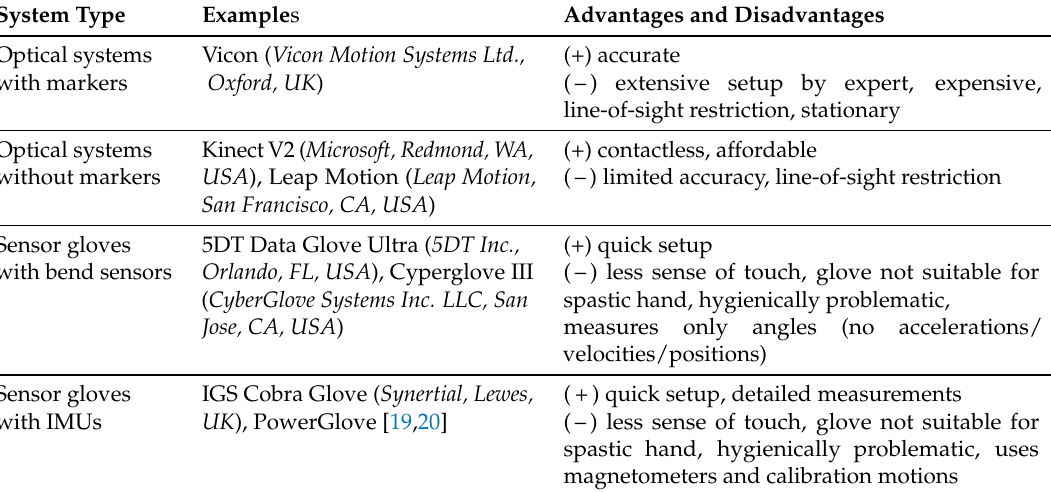
Table 1. Overview of suggested hand motion tracking systems for clinical applications. This list does not claim to be complete and rather shows examples. The advantages and disadvantages refer to the use in closed-loop functional electrical stimulation for